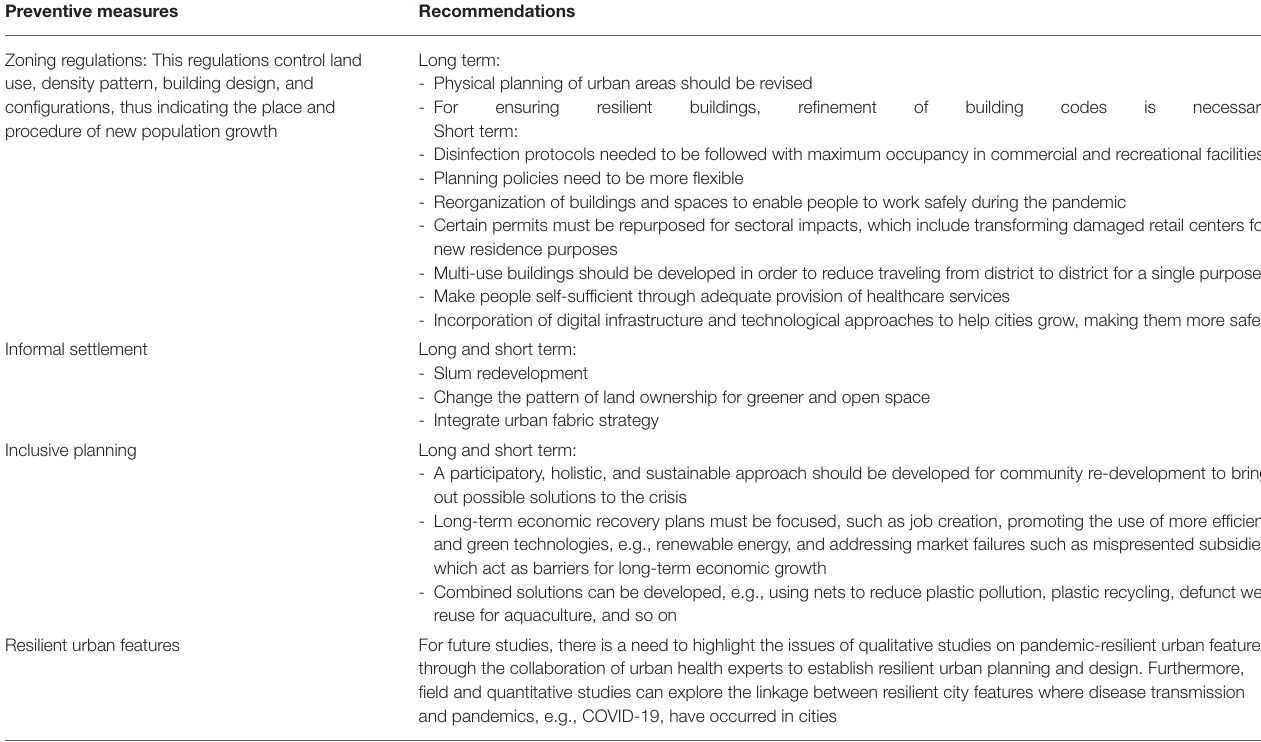
TABLE 2 | Short- and long-term recommendations for pandemic-resilient urban planning and design. Preventive measures